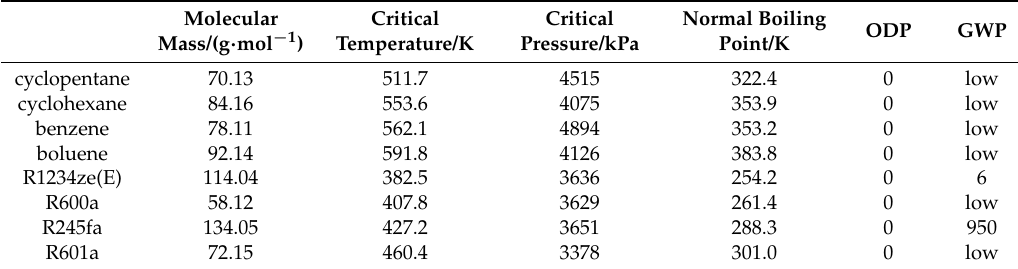
Table 1. Working fluids properties. ODP: ozone depletion potential; GWP: global warming